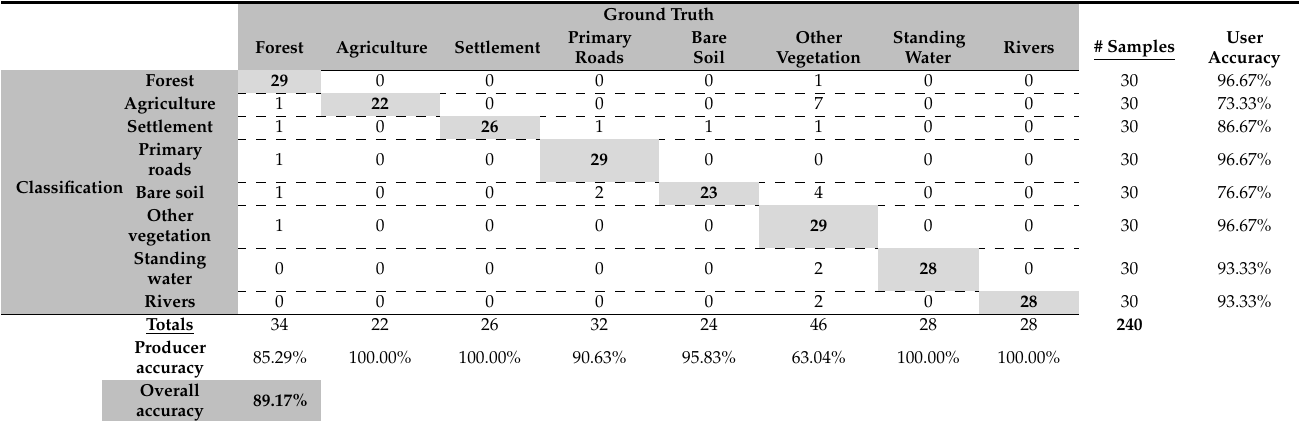
Table 7. Validation Matrix for Service 1: LULC classification for epoch